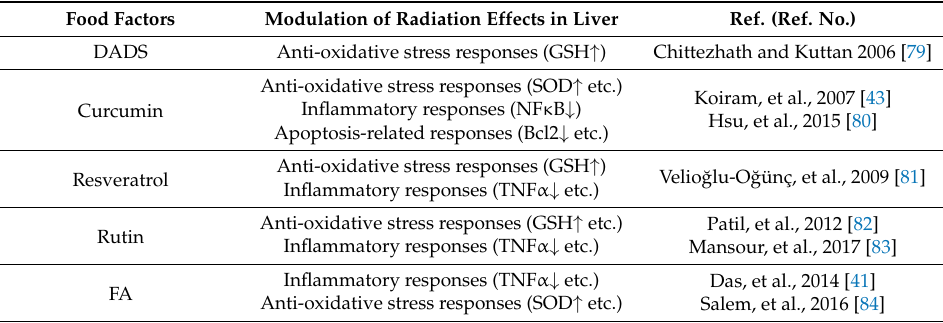
Table 3. Modulation of radiation effects in the liver and liver cells by food factors. Food Factors Modulation of Radiation Effects in